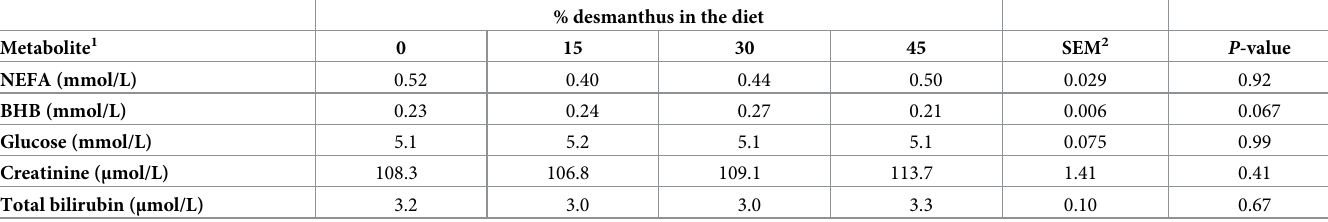
Table 7. Plasma metabolites of tropical beef cattle fed increasing levels of desmanthus.